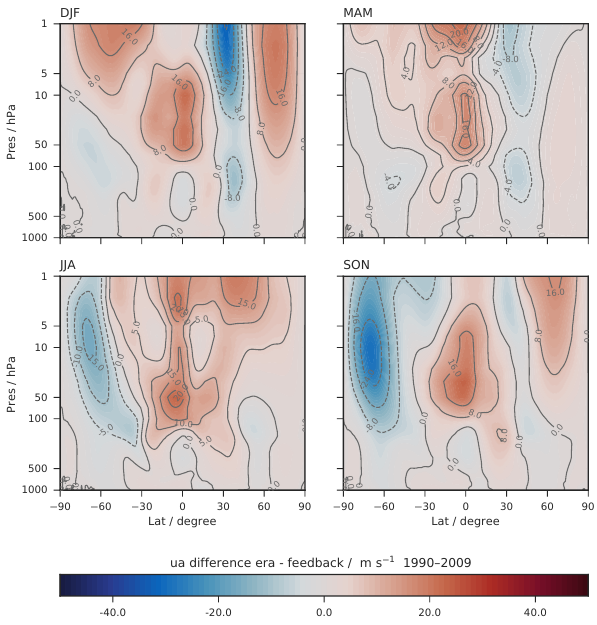
Figure 12. Latitude–height cross sections of seasonal and zonal mean zonal wind differences (ms − 1 ) for ERA-Interim minus feed- back